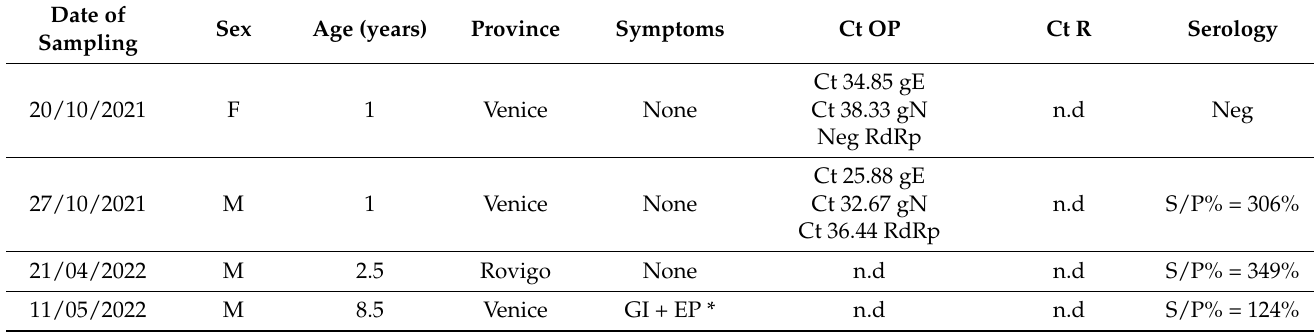
Table 3. Description of the positive cats: anamnestic and epidemiological data, molecular, and serological analysis’